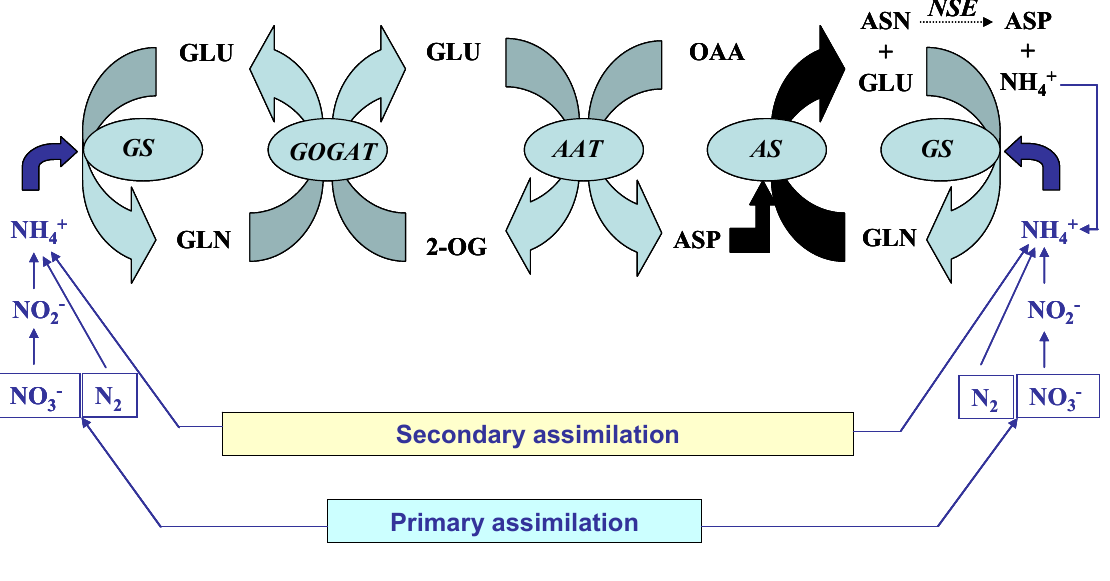
Figure 2. Enzymes involved in glutamine metabolism. GS, glutamine synthetase; GOGAT, glutamate synthase; AAT, aspartate aminotransferase; AS, asparagine synthetase; NSE,